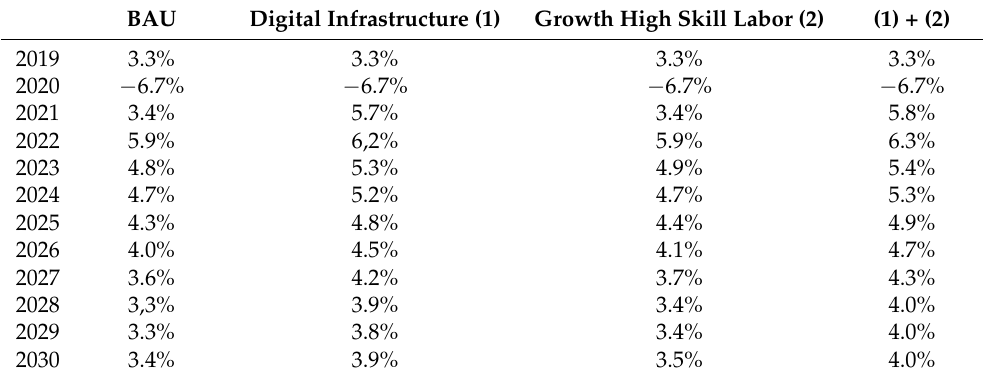
Table 7. GDP growth projections from CGE simulation digital infrastructure development (DID) reforms.